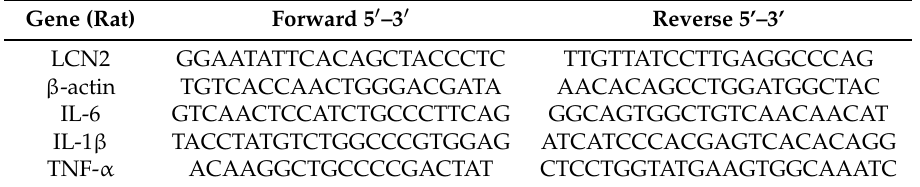
Table 1. Gene-specific synthesized forward and reverse primer sequences used for RT-PCR